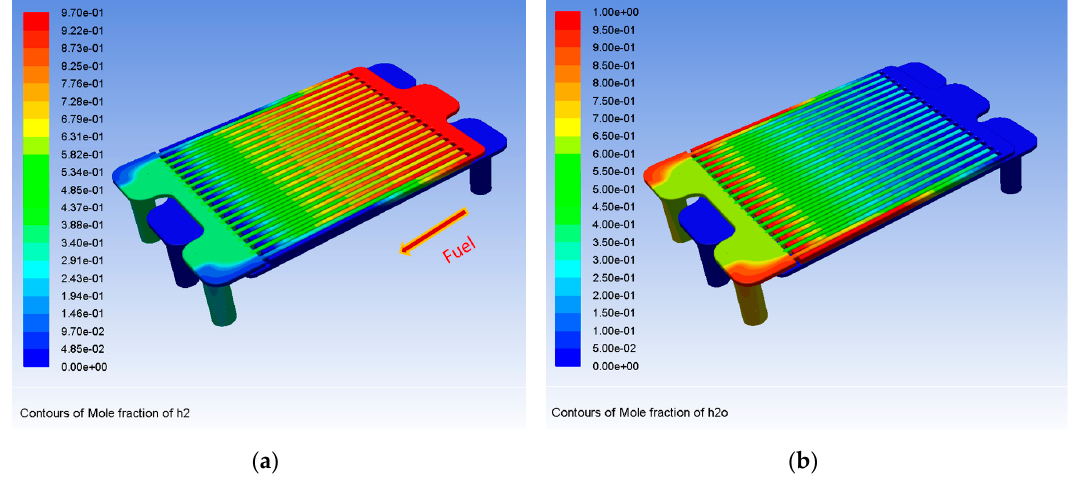
Figure 4. Mole fractions of fuel within the anode side: ( a ) H2, ( b ) vapor. (note: e-01 in the figure means × 10 − 1 ).